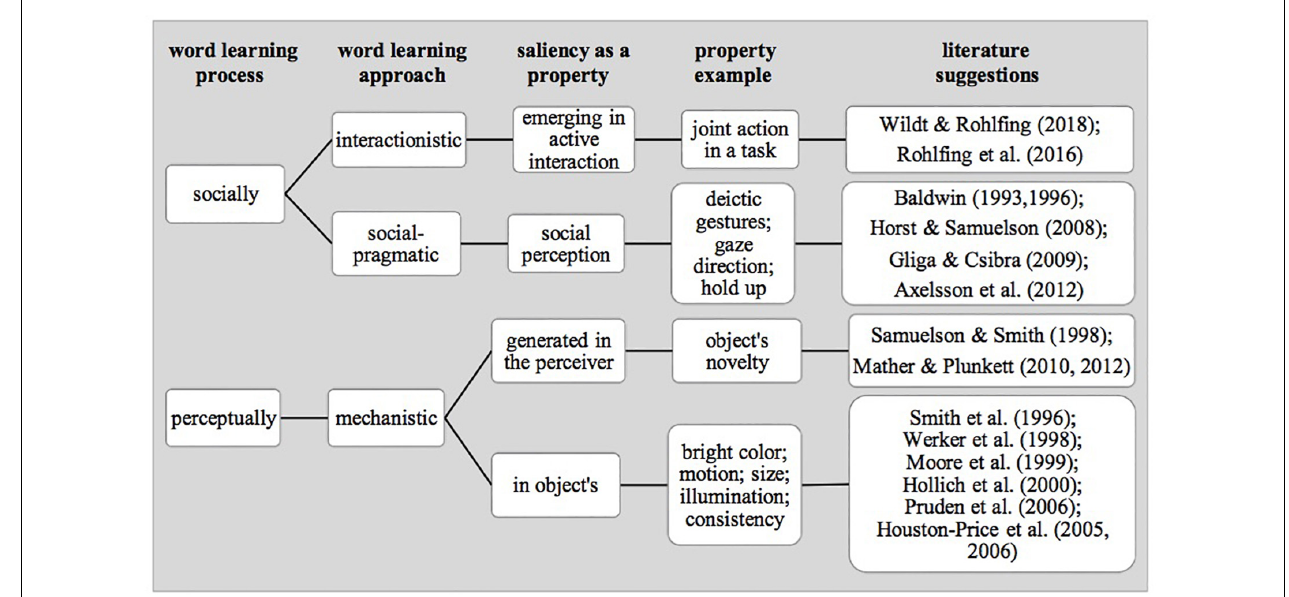
FIGURE 1 | State of research on saliency (emerging from perceptual biases, social cues, or interactions) in the context of early word learning.